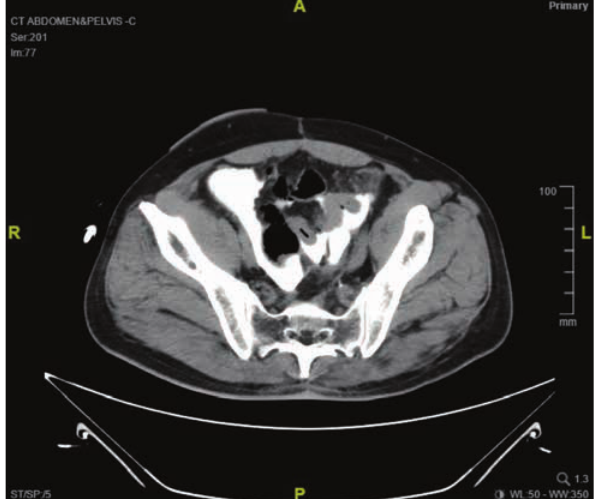
Figure 6: (Case 2) Intraoperatively, small perforations noted at the descending colon just proximal to anastomosis area, with genera- lised contamination of peritoneal cavity with turbid contrast